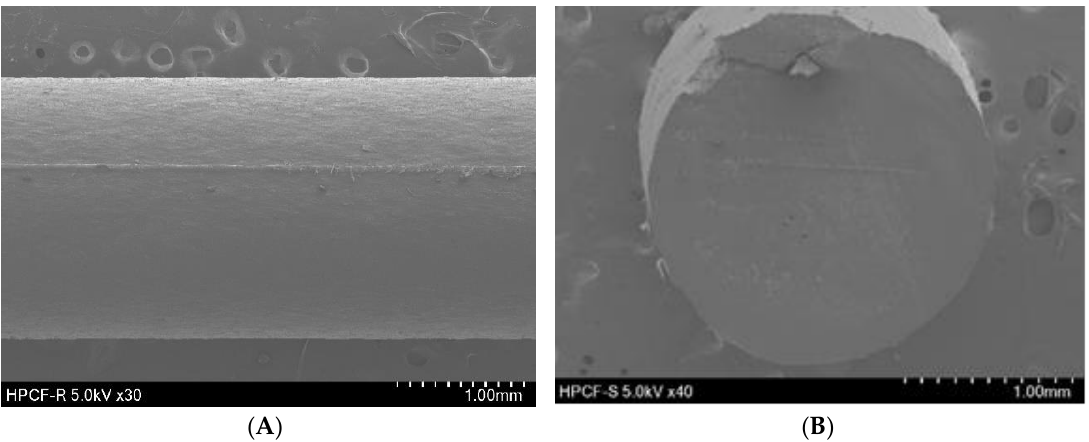
Figure 1. SEM images of hot-melt extruded filament. ( A ) Exterior appearance (30×) and ( B ) cross sectional shape (40×).